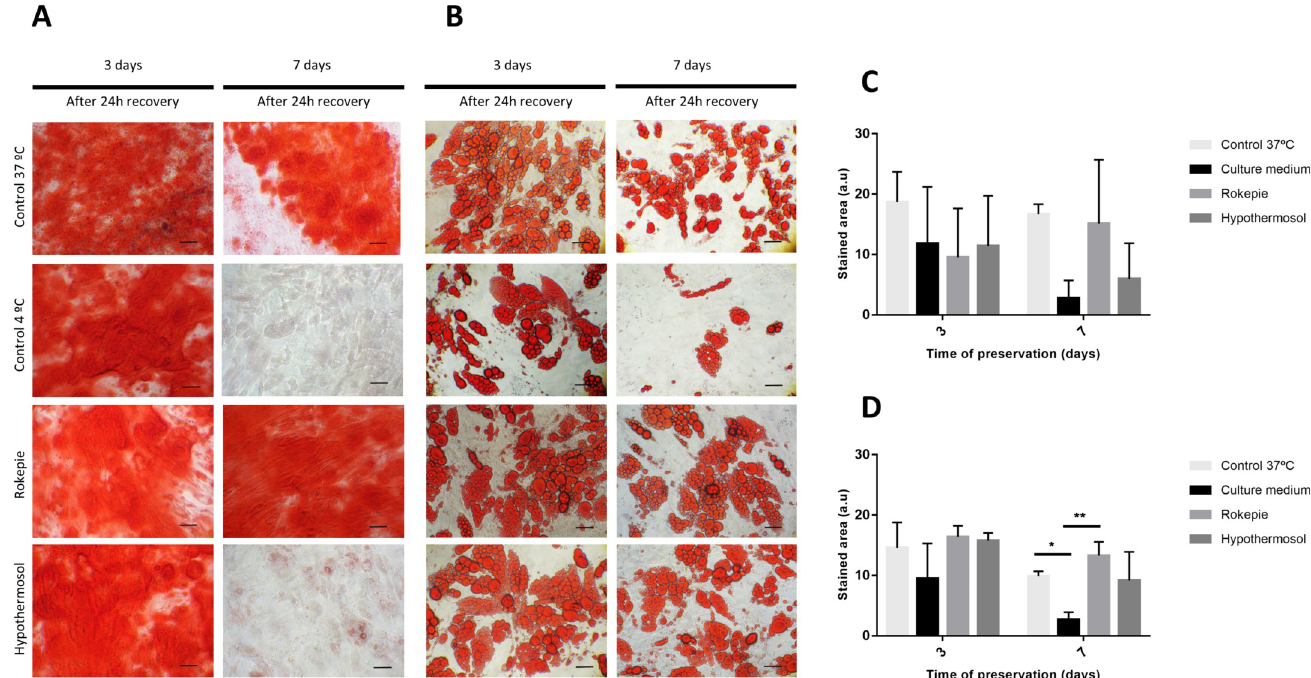
Fig 6. Differentiation potential and stained area quantification. Representative images of the differentiation potential and stained area quantification in confluent hASCs preserved at 4˚C, in the presence and absence (Culture medium) of hypothermic storage solutions for 3 and 7 days. A control culture at 37˚C was also included. A) Alizarin Red S staining for mineralization during osteogenic differentiation. B) Oil Red O staining for lipid accumulation during adipogenic differentiation. Scale bar: 100 μ m. C) Quantification of alizarin red S stained area by ImageJ software. D) Quantification of Oil red O stained area given by ImageJ. Stained area values are presented as mean ± stddev and were analyzed using one-way ANOVA and Tukey’s post-tests ( � p < 0.05 and �� p <